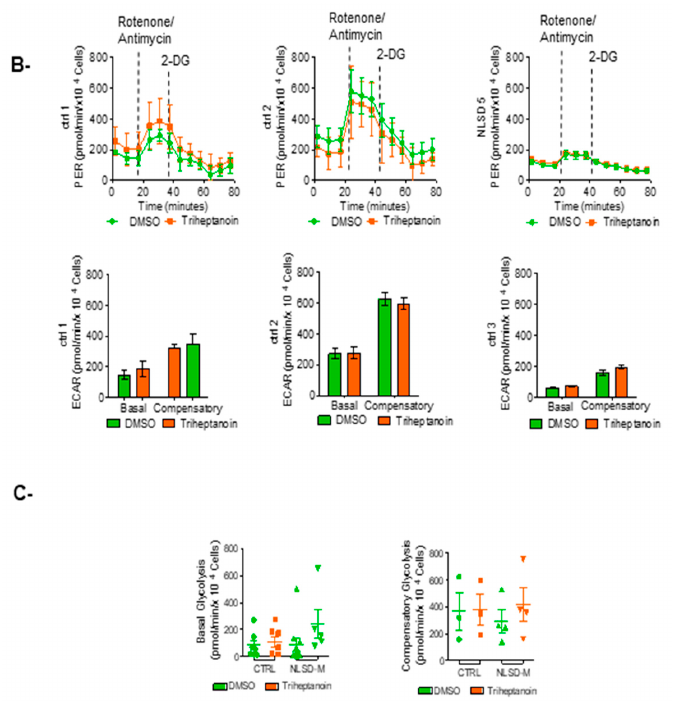
Figure 2. Glycolytic respiration of fibroblasts treated with triheptanoin. Profile of the glycolytic activity measured in ( A ) NLSD fibroblasts and in ( B ) normal fibroblasts. Histograms represent basal glycolysis and compensatory glycolysis. ( C ) comparation of glycolytic respiration parameters between controls (CTRLs) and NLSD-M samples. Data are presented as mean ± SD. Statistical significance was evaluated through Mann–Whitney test. * p ≤ 0.05, ** p ≤ 0.005, *** p ≤ 0.0005. PER (proton efflux rate). Table 4. Glycolytic